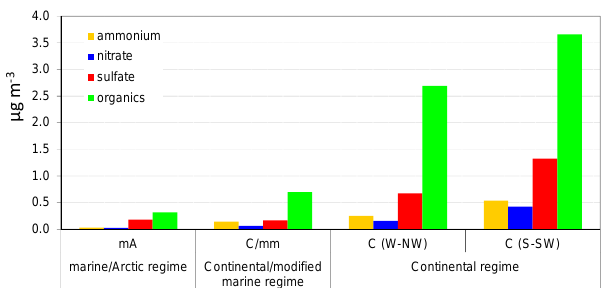
Fig. 3. PM 1 chemical composition (Q-AMS) averaged within the four distinct periods of Fig.